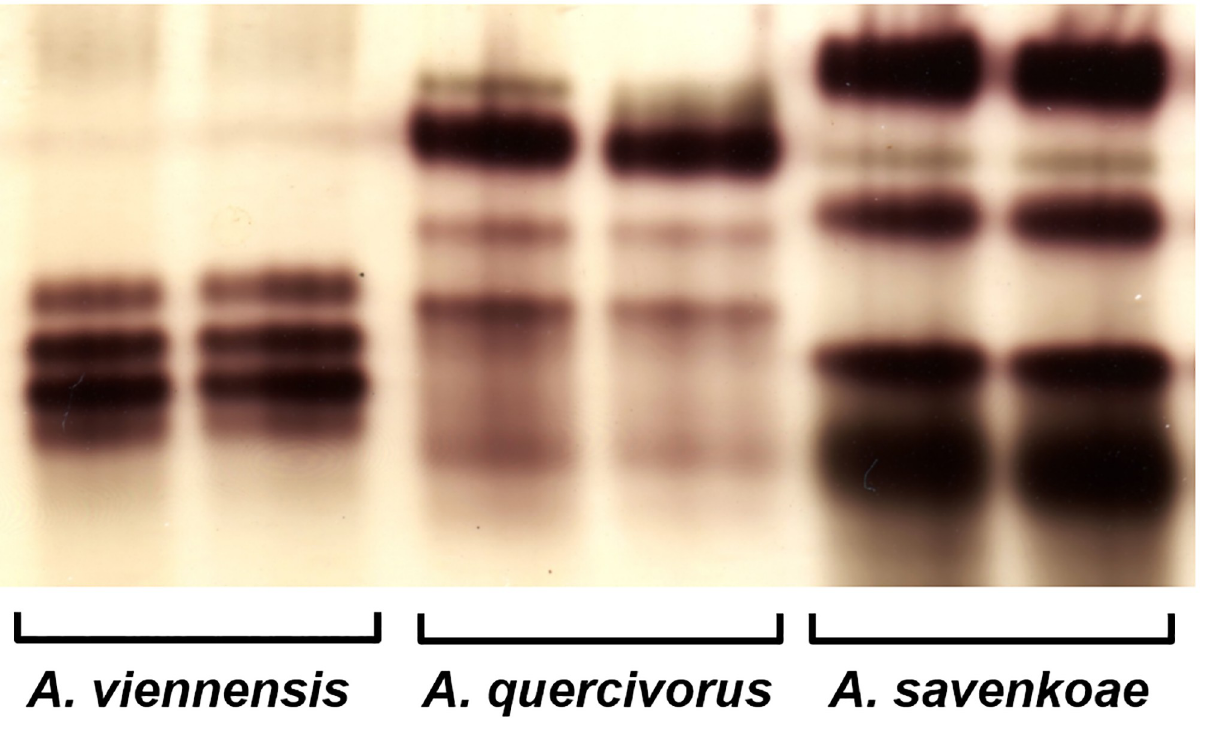
Fig 10. Esterase zymograms of A . viennensis (Chiyoda, voucher specimen no. 885), A . quercivorus (Tsukuba, no. 610) and A . savenkoae (Kherson, no.